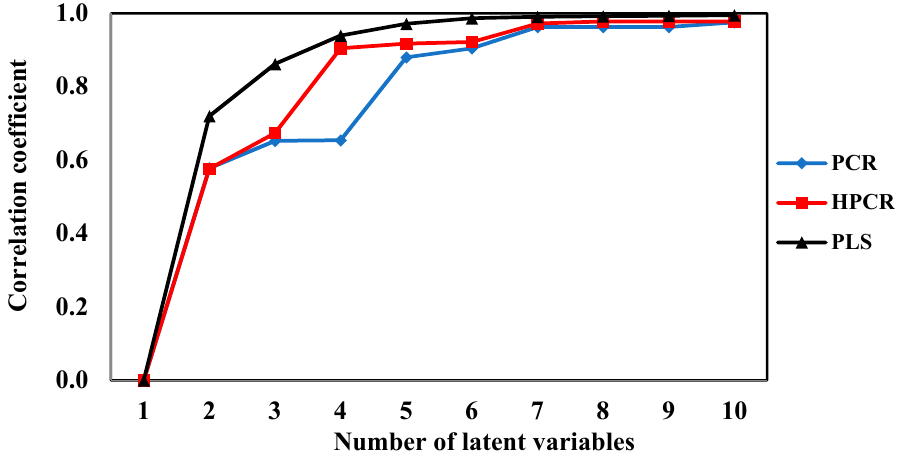
Figure 7. Calibration objective functions for PLS, PCR and HPCR models at 90 °C and 450 rpm.